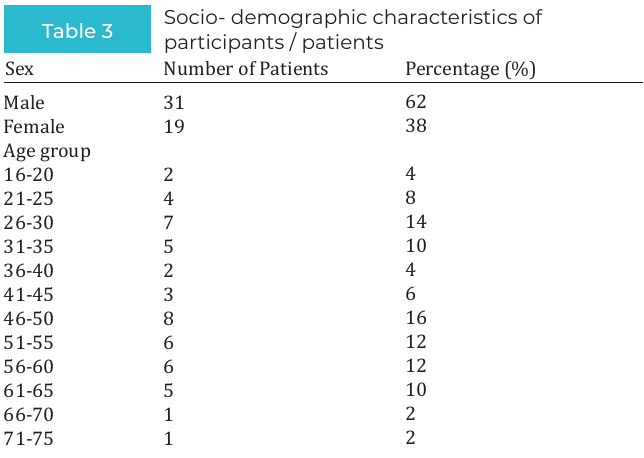
Presence of tumor in a different location